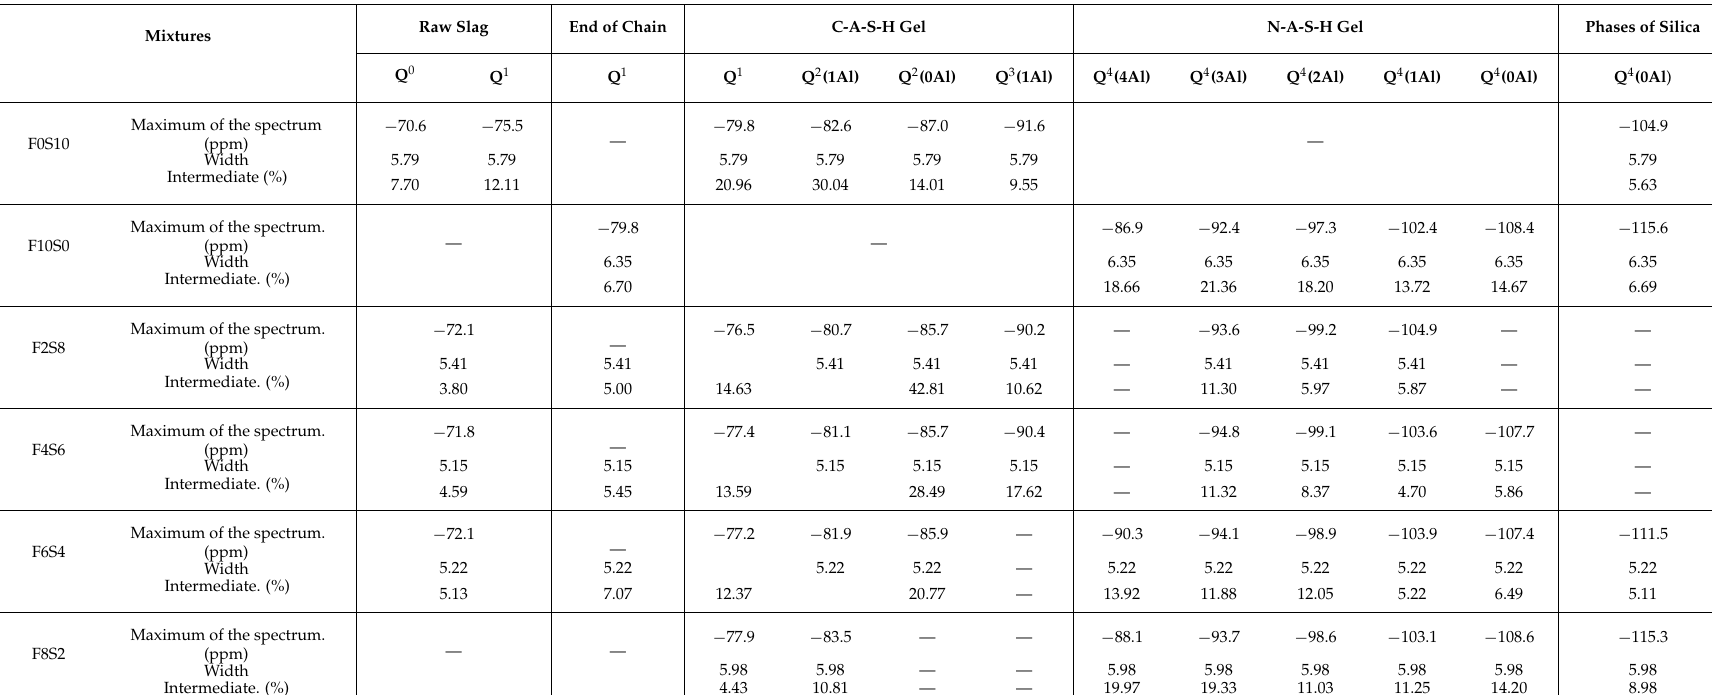
Table 4. 29 Si MAS NMR data of alkali-activated